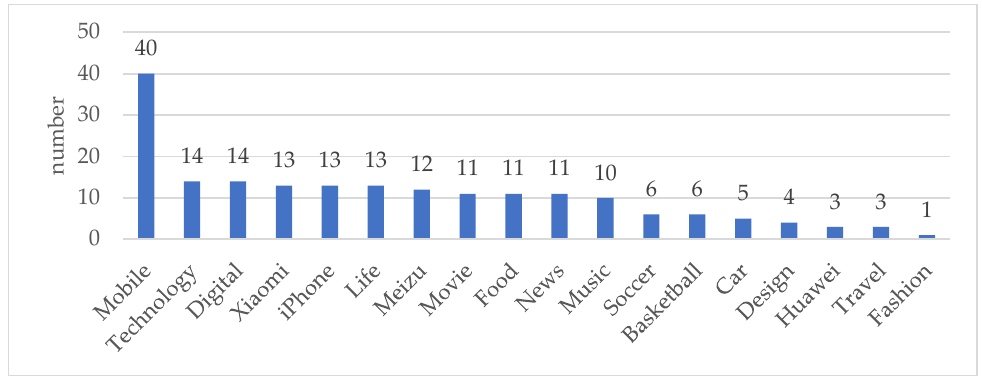
Figure 10. Statistical results of keywords in users’ interest profiles .